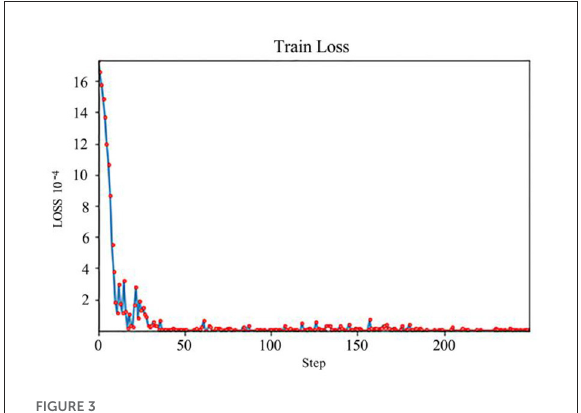
FIGURE3 Convergence process of loss function of feedforward neural